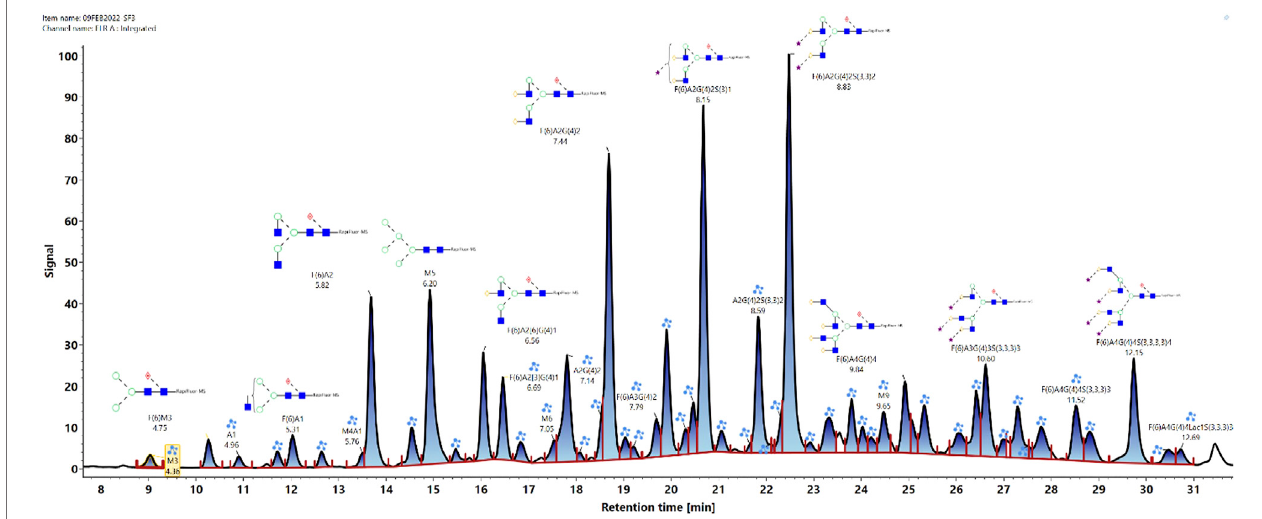
FIGURE 1 | Released N-glycan map from the FLR channel of the HILIC- UPLC-FLR-MS analysis of VRC01 mAb. In total 53 glycans were identi fi ed and annotated (44 were identi fi ed and annotated based on GU and accurate mass, while 9 of them were based only on GU values).